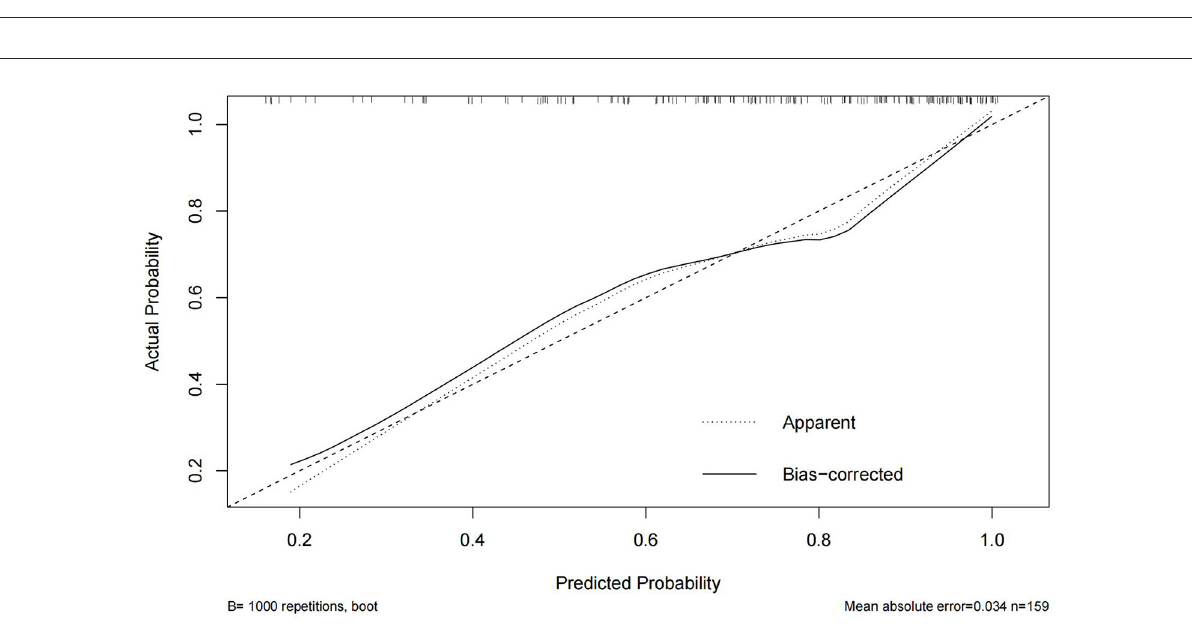
FIGURE1 Nomogram of Hypertension, years of schooling, Hcy, and Total CSVD MRI Score.